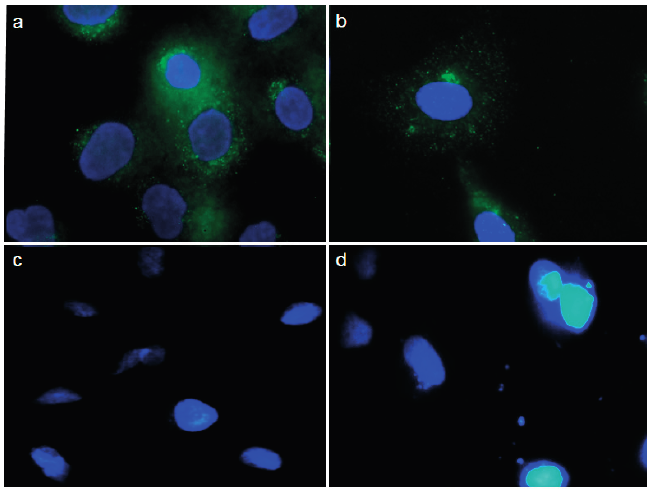
Figure 3. Subcellular localization of E/V5 fusion protein. Recombinant E protein (E-V5) was detected using anti-V5-FITC antibody (green) in HTC-116 ( a ) and MC-38 ( b ). No stain was observed in T-84 ( c ) and CCD18co ( d ) cells following pCEA - E treatment. Twenty-four hours after transfection, the fluorescence pattern was dotted and located in the cell cytoplasm. Cell nuclei were stained by DAPI (blue). Magnification: 40×.